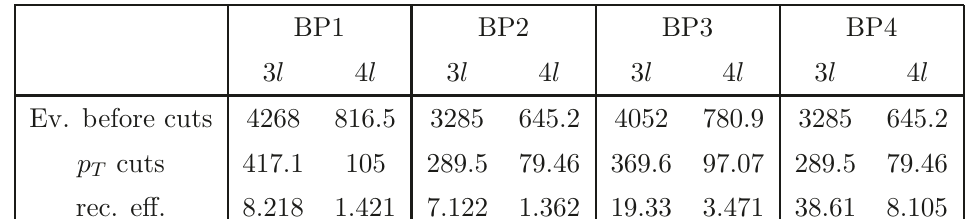
Table 8. Displaced leptons originated from heavy neutrinos produced by the SM-like Higgs. For each BP the initial number of events generated is the cross section σ ( pp by a luminosity of 100 fb − 1 . A 3 l -trigger has been employed. The p T cuts are applied in the following way: p T > 20 GeV for the two most energetic leptons and p T > 10 GeV for the third one. A p T > 5 GeV is required on the forth lepton, when present. Only the events surviving the final selection procedure and the cuts on the p T are shown.